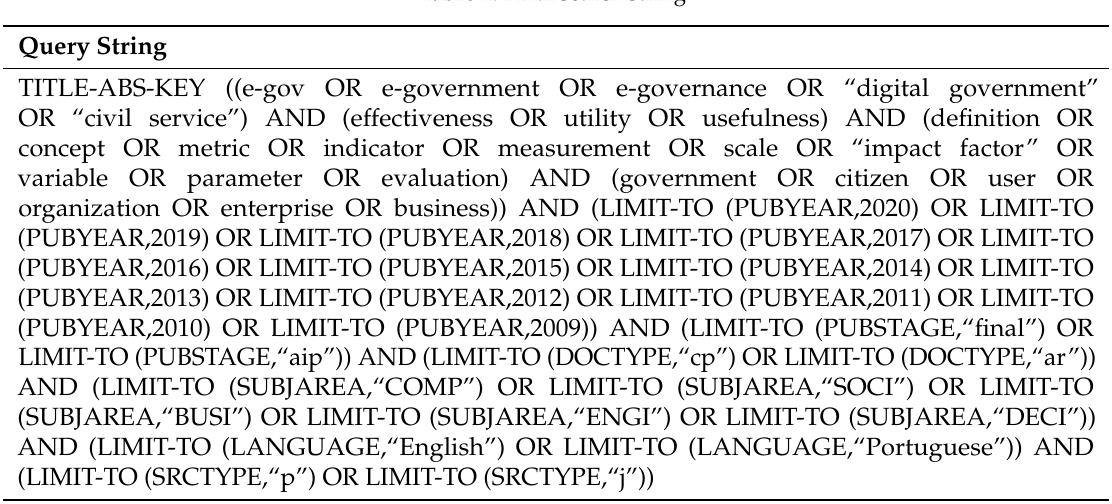
Table 2. Final search string.